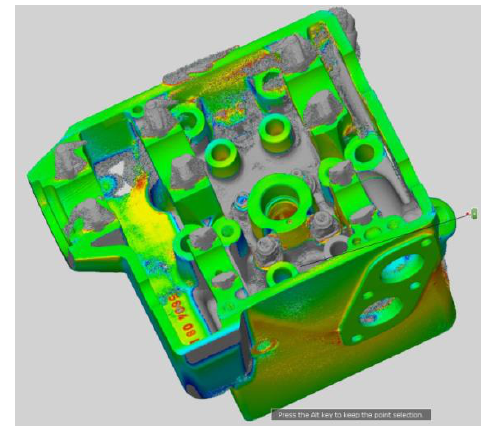
Fig. 14. Comparison of the developed model with the image obtained by scanning along with the specified deviations